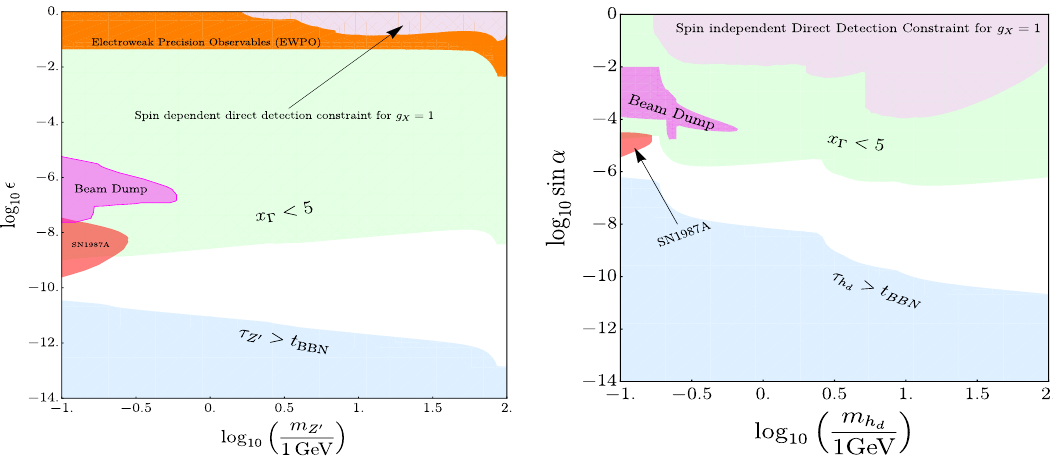
Figure 4 . Left panel : allowed parameter space in the m Z 0 − (cid:15) plane. The light blue shaded region is disallowed from the BBN and the light green region is disallowed from the requirement of a kinetically decoupled dark sector. The Magenta and red shaded regions are disallowed from Beam dump experiments and SN 1987A cooling respectively. The Constraints from EWPO and direct detection cross section are shown by the orange and the purple coloured regions respectively. Right panel : allowed parameter space in m h − sin α plane. Colour code is same as the left d